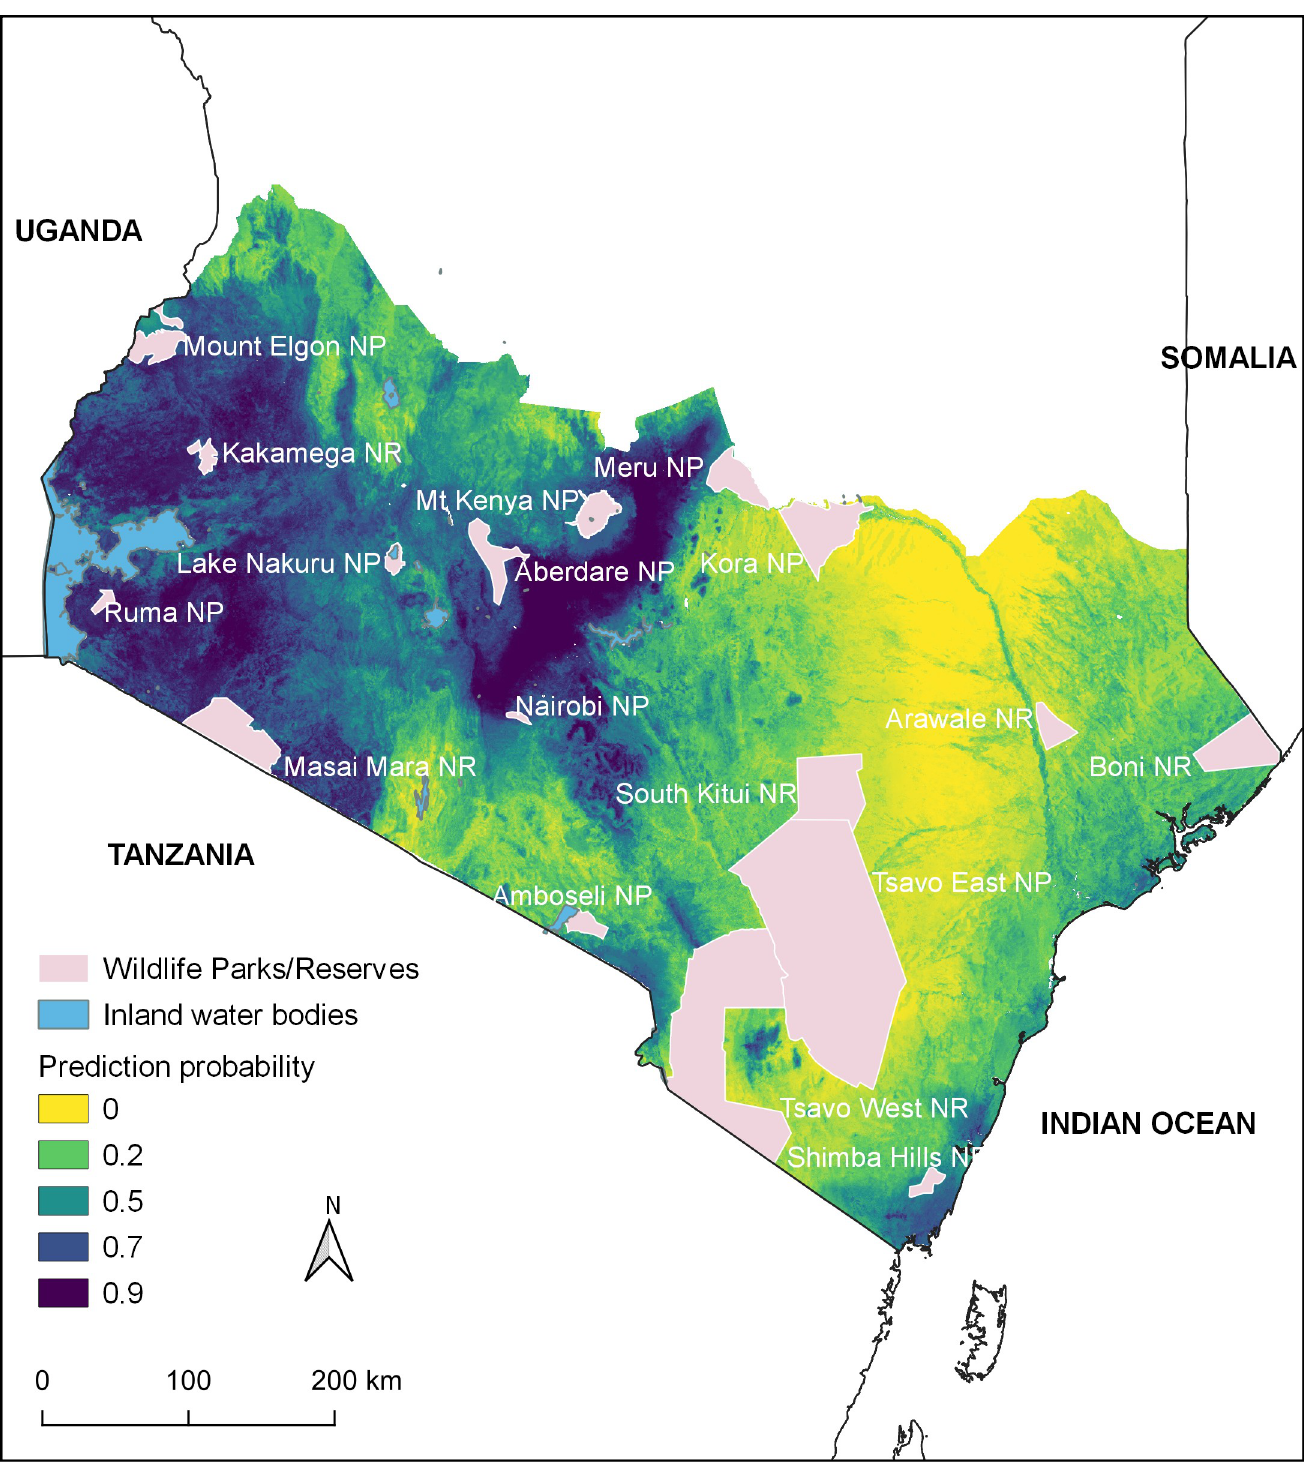
Fig 3. Location of National Parks and Game Reserves overlaid on the predicted distribution of anthrax in southern Kenya based on boosted regression tree experiments.